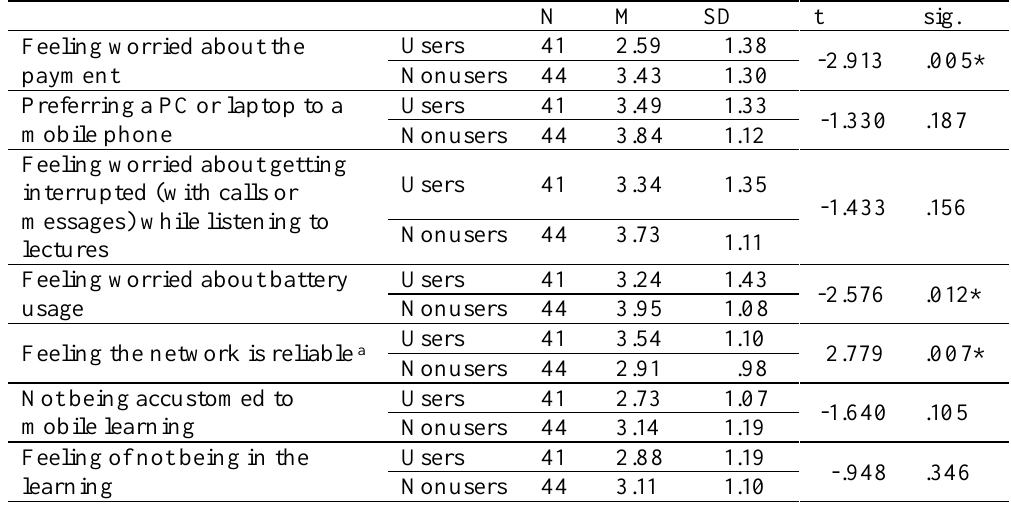
Mean, Standard Deviation, and T-Test Results for Resistance N M SD t